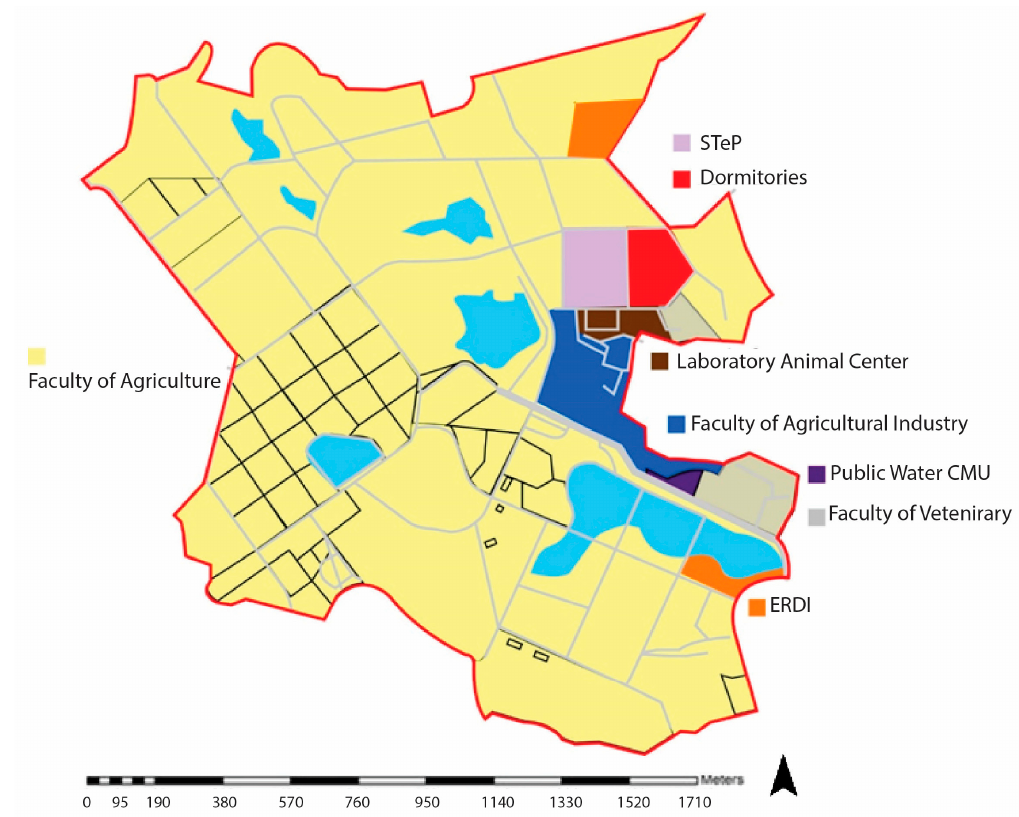
Figure 1. Stakeholders outside of the Faculty of Agriculture within the Rai Mae-Hia